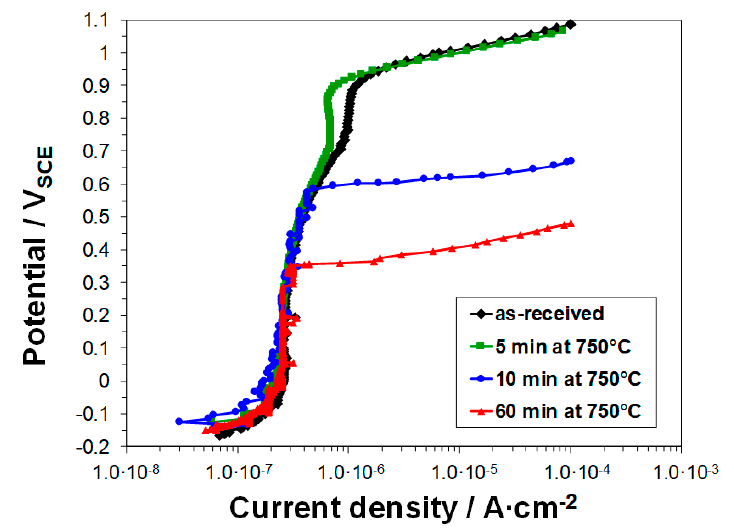
Figure 3. Anodic polarization curves recorded in 1 M NaCl solution at 20 °C on both as-received and aged DSS 2304.